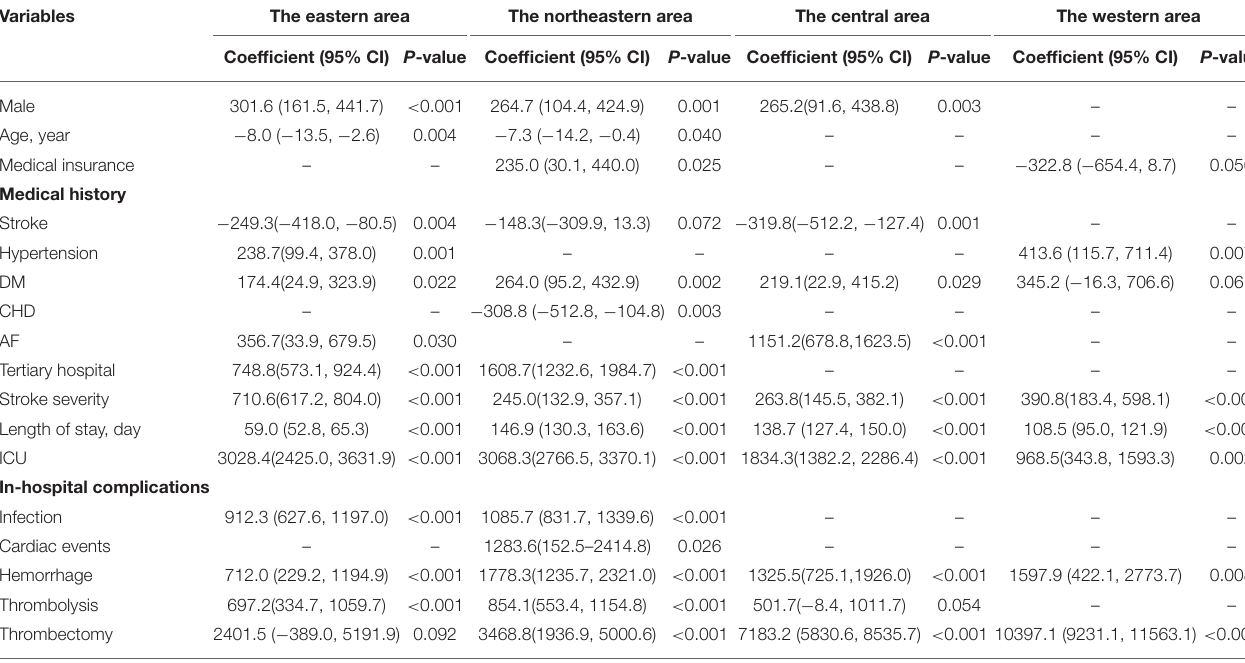
TABLE 5 | Multivariate analysis of hospital costs in different areas. Variables The eastern area The northeastern area The central